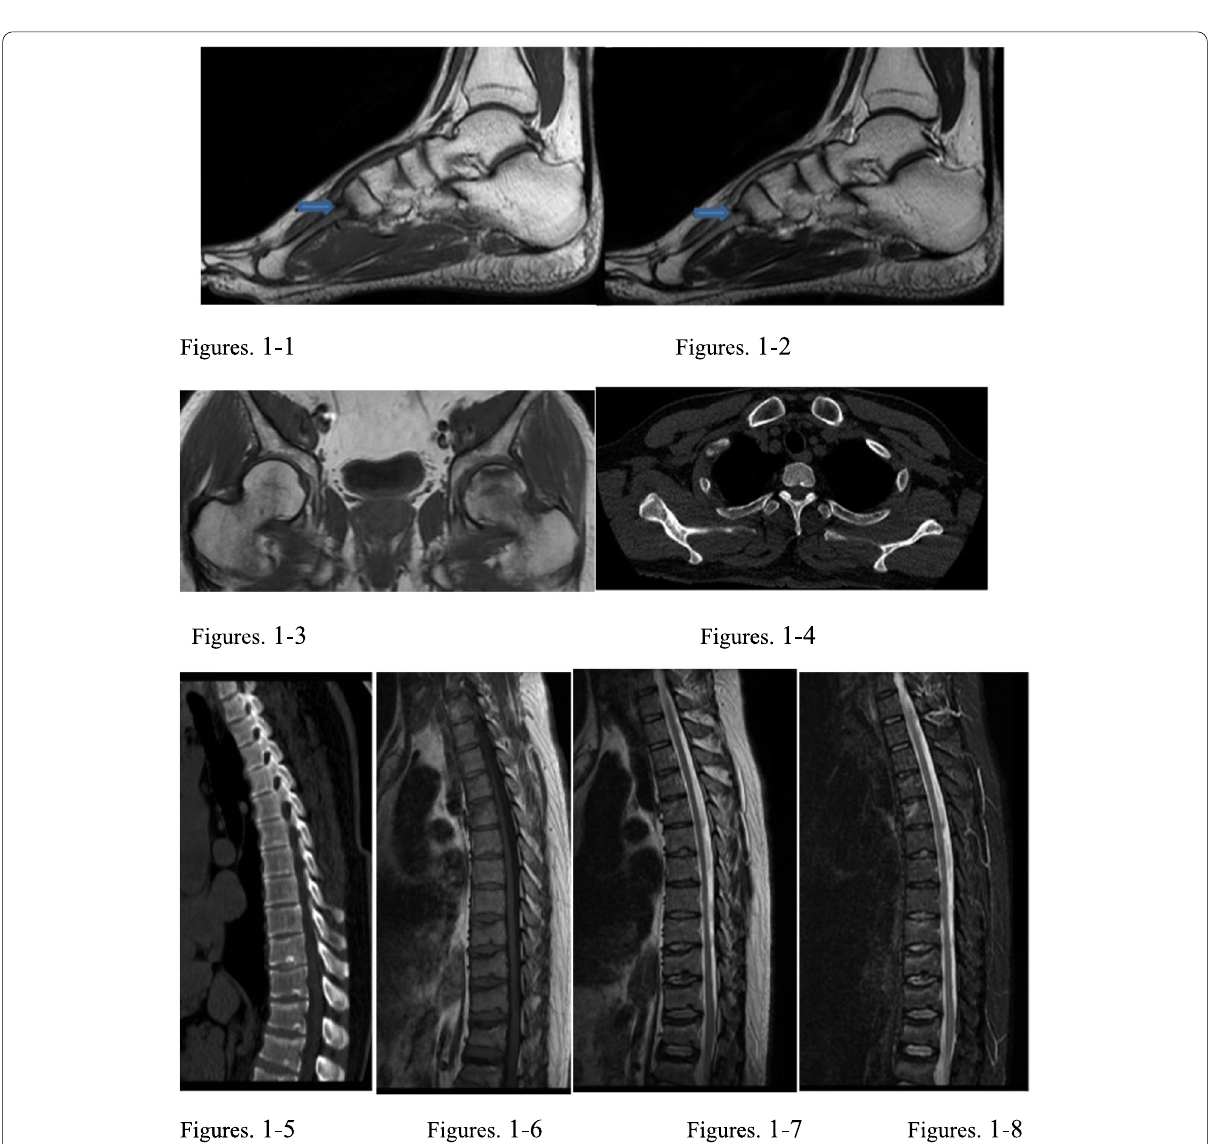
Fig. 1 2018 T1WI, T2WI, proximal second metatarsal linear T1WI, T2WI low signal shadow fracture line (indicated by arrow). 1-3 2018 MRI T1WI left femoral head avascular necrosis. 1-4 CT right third anterior rib fracture in 2020. 1-5 – 1-8 2020 thoracic spine CT, T1WI, T2WI, STIR image, T4–5, and T9–L1 compression